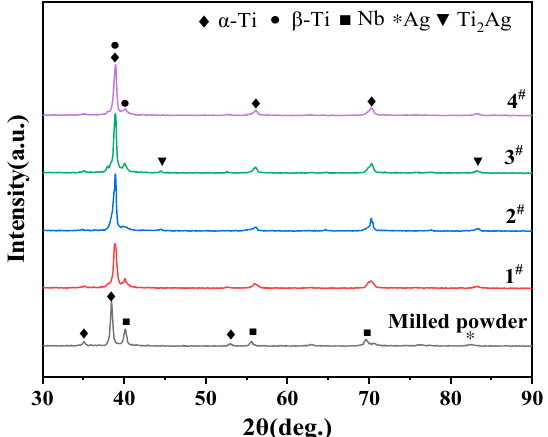
Figure 3. The XRD patterns of Ti-40Nb-10Ag milled powders and Ti-40Nb-10Ag alloy for different sintering temperature.